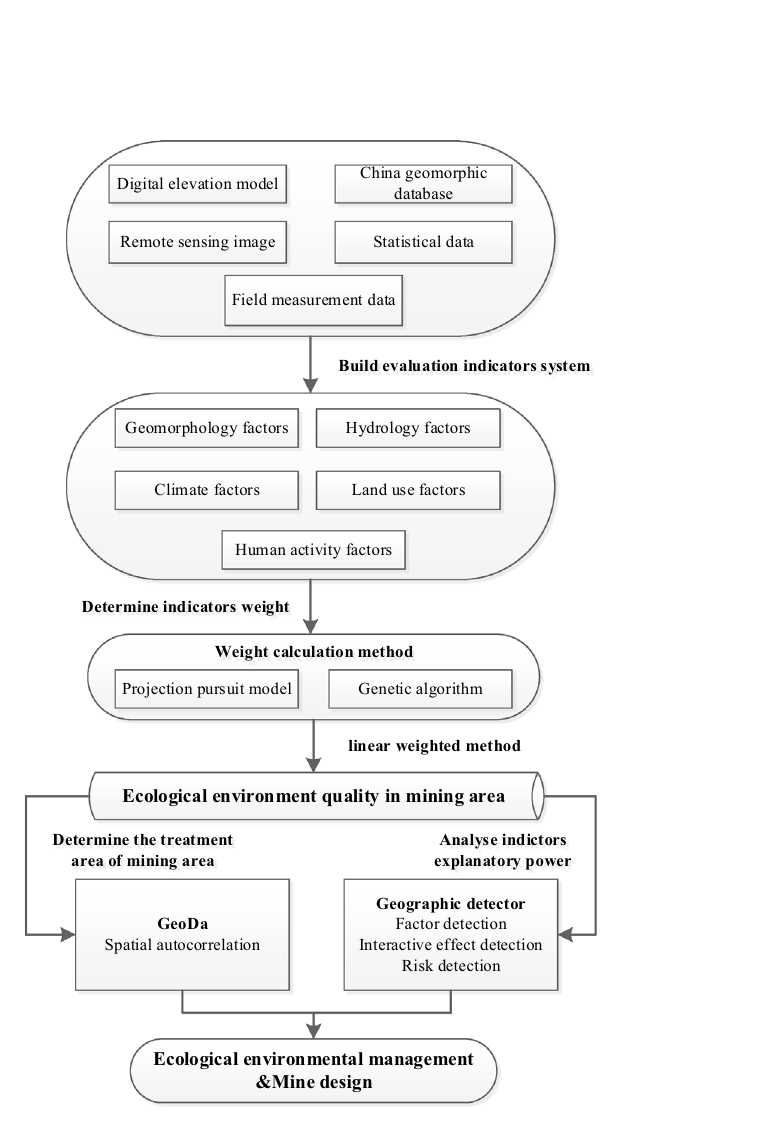
Figure 2. Research